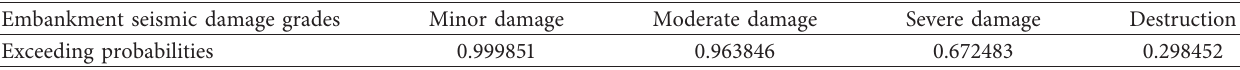
Table 8: Exceeding probability of each seismic damage grade at the epicenter of the Chi-Chi earthquake [65–67]. Embankment seismic damage